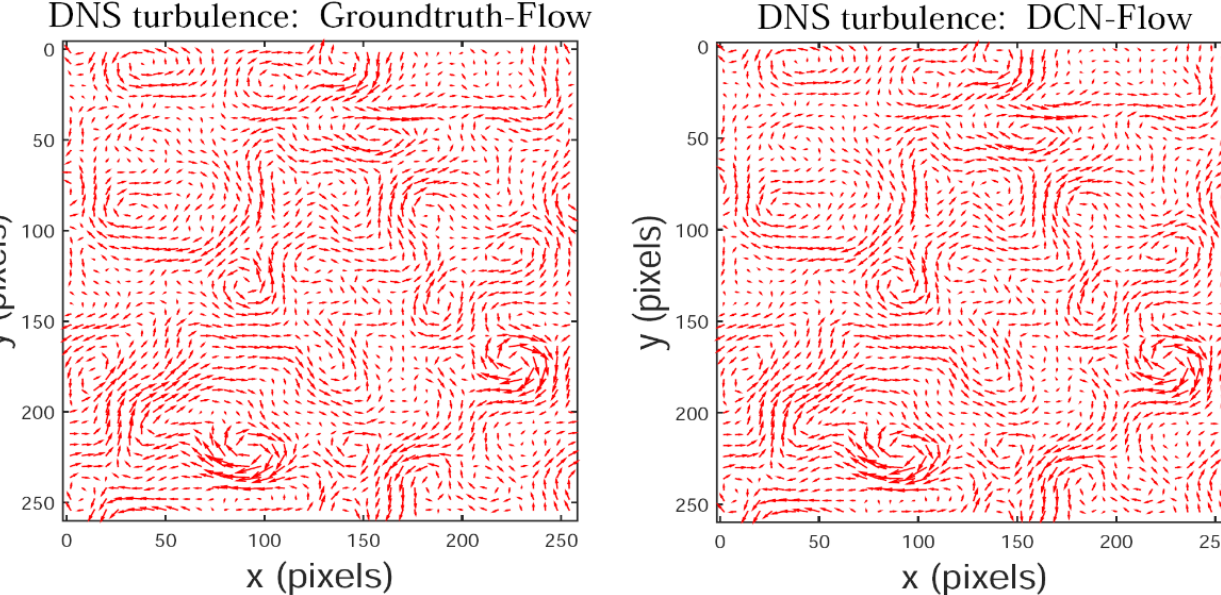
Figure 8. The flow vectors of DNS-turbulence estimated by our method (DCN-Flow).